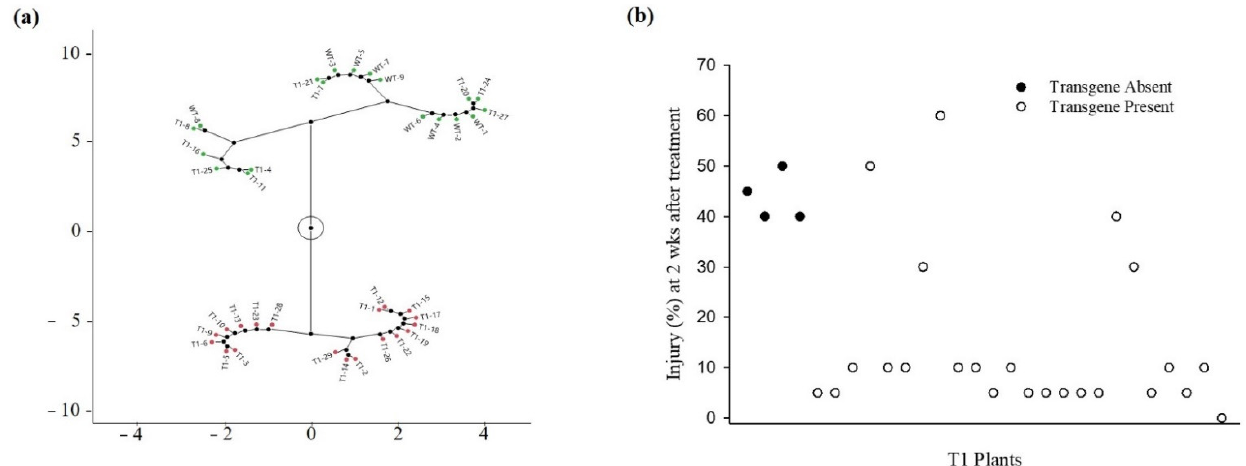
Figure 1. Response of transgenic rice plants to foliar-applied fomesafen (780 g ha − 1 ). ( a ) Constellation plot from the hierarchical clustering analysis of T 1 and wild type (WT) injury data collected 2 weeks after foliar treatment. Cluster 1 (red) is composed of plants showing low injury. Only T 1 plants were part of cluster 1. Cluster 2 (green) is composed of plants showing high injury. Both WT and T 1 were present in cluster 2. ( b ) Scatter plot of foliar injury levels of T 1 plants with (white circles) or without (black circles) the Δ G210-Apppo2 transgene.